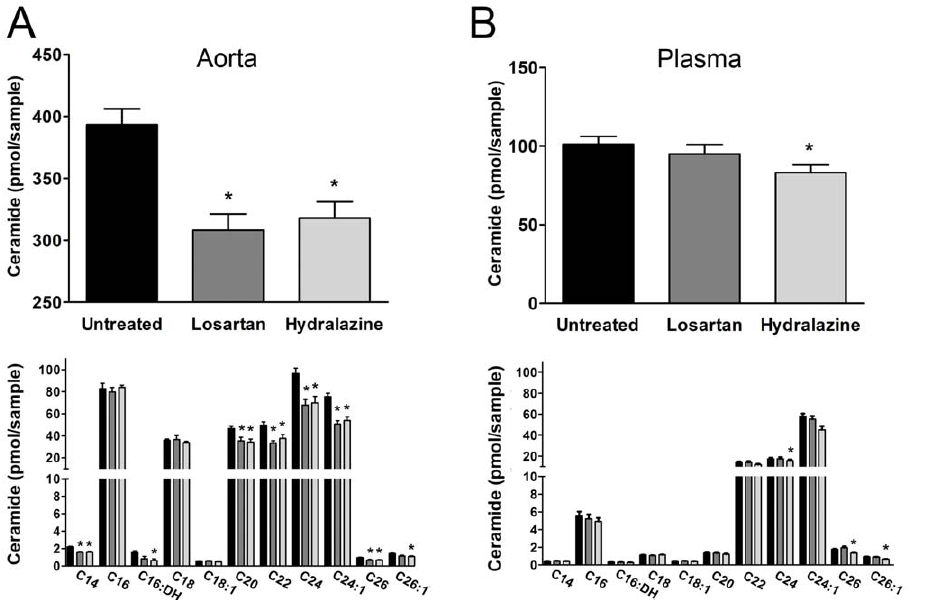
Figure 2. Losartan and hydralazine lower vascular but not plasma ceramide levels in SHR. Ceramide levels (top: total ceramide, bottom: ceramide subspecies) were measured in ( A ) aorta and ( B ) blood plasma of untreated, losartan-treated or hydralazine-treated SHR. Data are presented as mean 6 SEM, n=8, * p , 0.05. Ceramide subspecies depicted as separated by different tail length. DH: dihydroceramide.